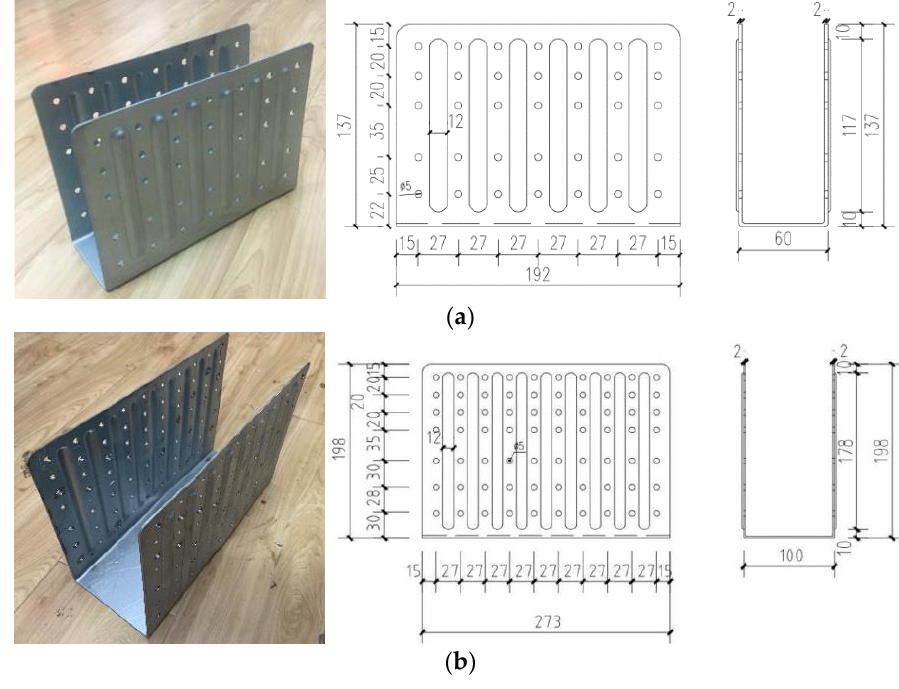
Figure 3. U connectors for assembling truss beams. ( a ) U60, ( b ) U100.